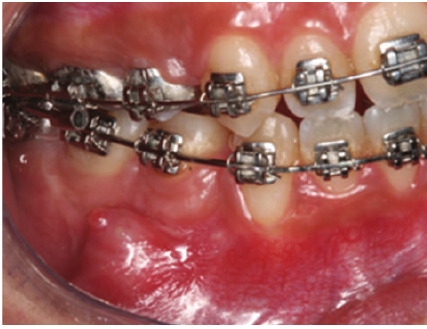
Figure 9: Soft tissue coverage of the orthodontic implant head.